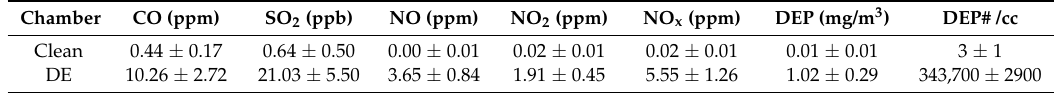
Table 1. The concentration of gases and particles in each